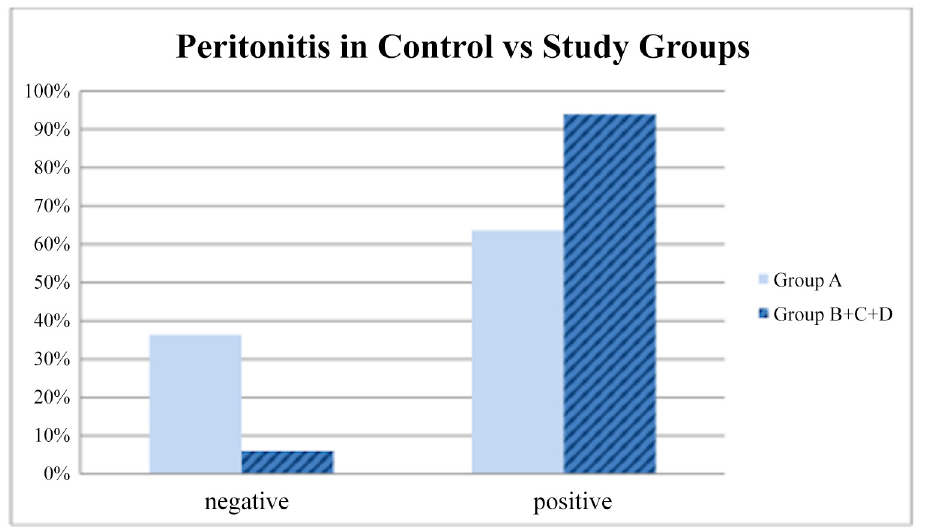
Fig 5. The percentage of peritoneal irritation in the sham group compared to all the other three groups together (P = 0,0269).